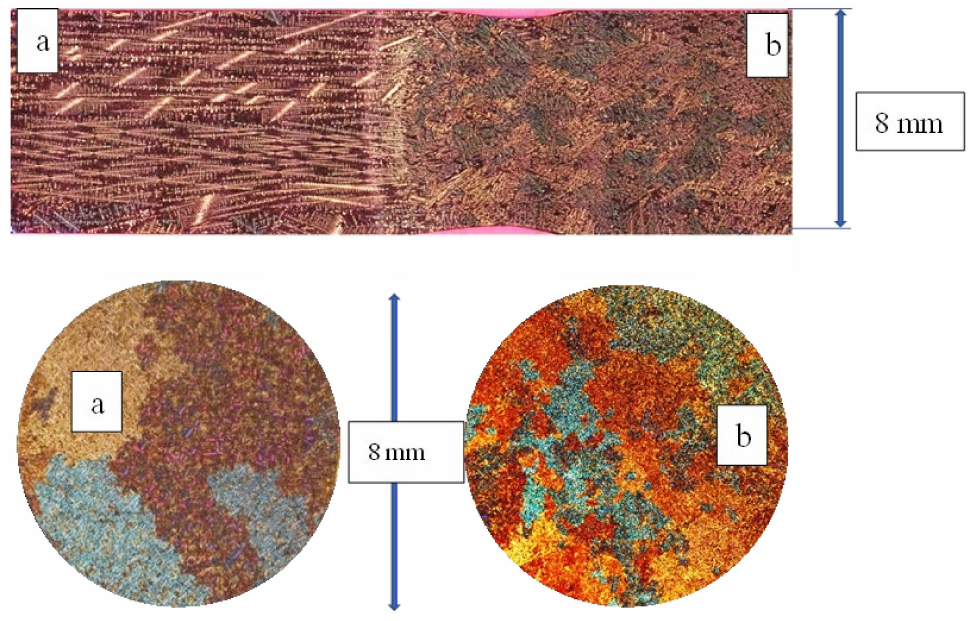
Figure 21. Columnar/equiaxed transition (CET). Longitudinal ( a ) and cross-sections ( b